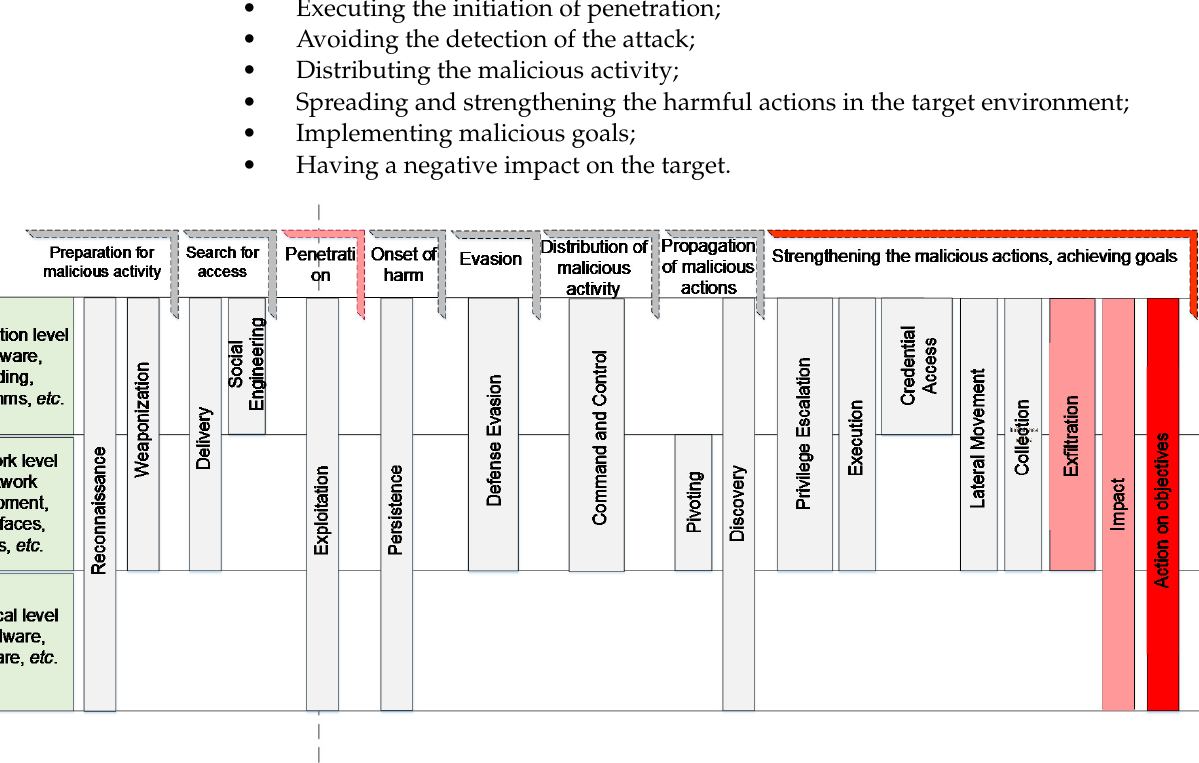
Figure 3. Link between stages of a cyberattack and malevolent intents on application–network– physical